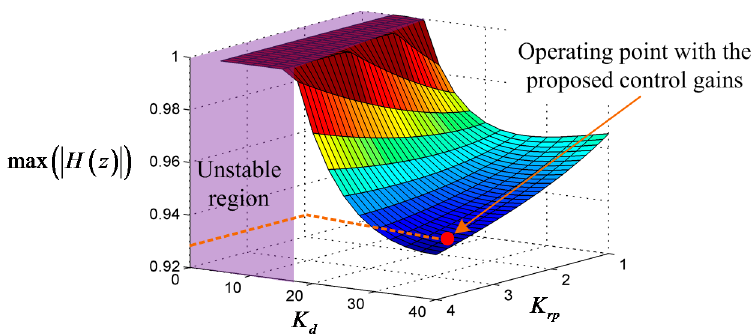
Figure 8. The maximum value of | H ( z )| under different K rp and K d .